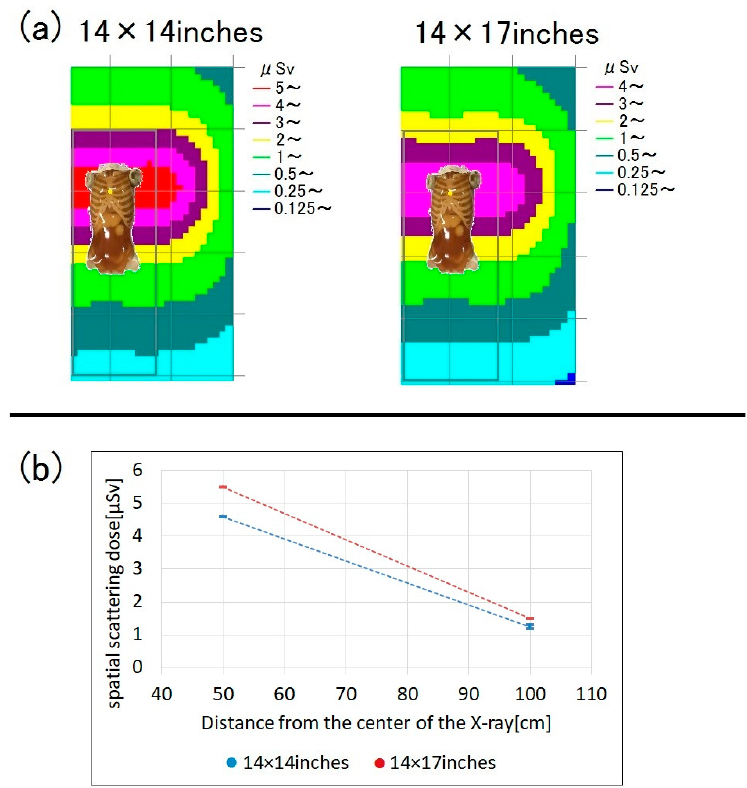
Figure 8. Spatial scattered radiation dose during chest radiography according to X-ray field size (14 × 14 vs. 14 × 17 inches; bed height = 80 cm; measurement height = 150 cm). ( a ) Dose-distribution map and ( b ) graph showing the spatial doses.